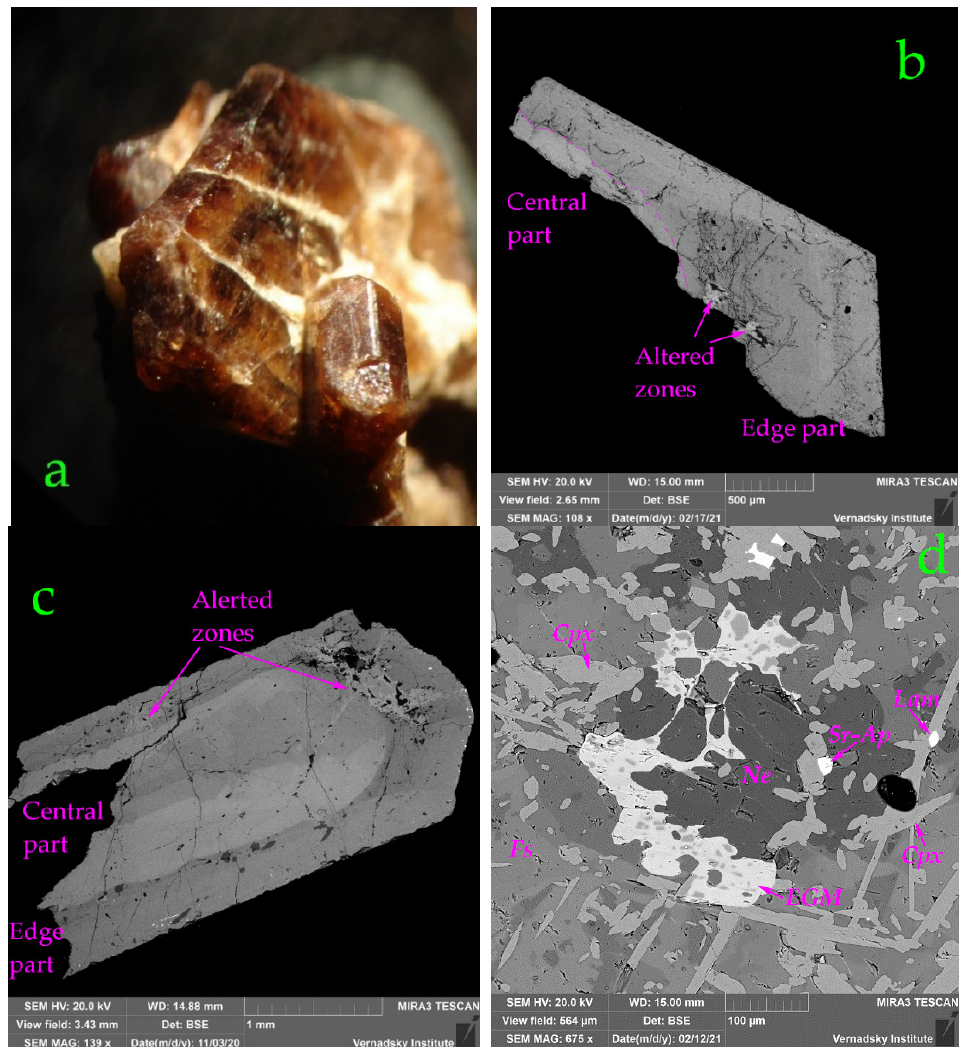
Figure 5. Optical photo ( a ) and BSE images of EGMs crystals ( b – d ).